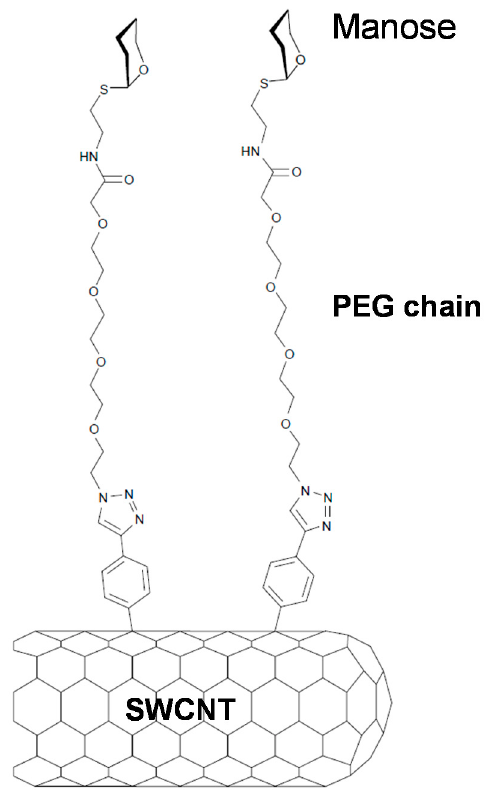
Figure 3. Single-walled carbon nanotube (SWCNT) modified with polyethyleneglycol (PEG) and mannose groups. From Reference [31] with permission of Elsevier.